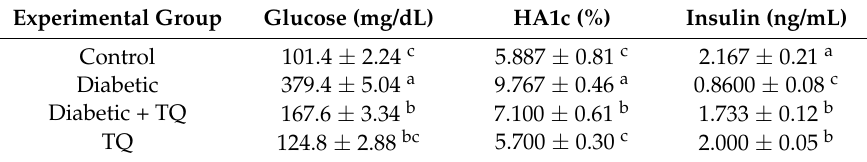
Table 1. Effect of thymoquinone (TQ) on serum glucose, insulin levels, and HA1c percentage in all experimental groups at the 12th week. Values are given as ±SEM, and Duncan’s range test ‡ was applied.